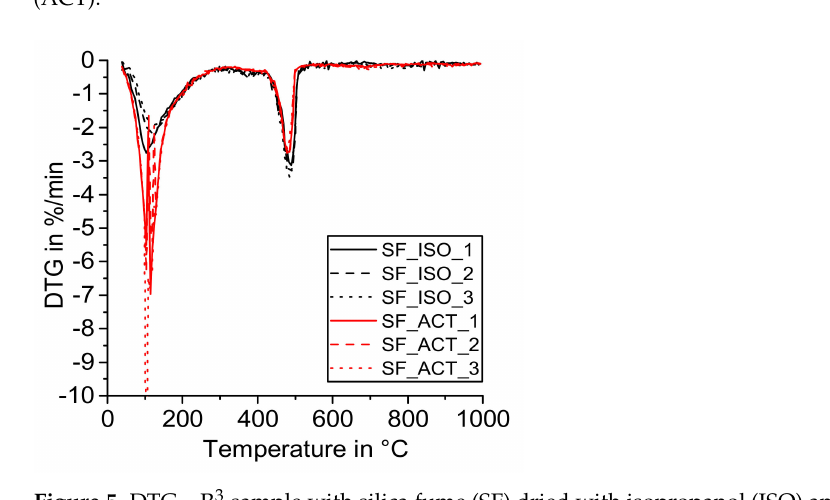
Figure 5. DTG—R 3 sample with silica fume (SF) dried with isopropanol (ISO) and acetone (ACT).